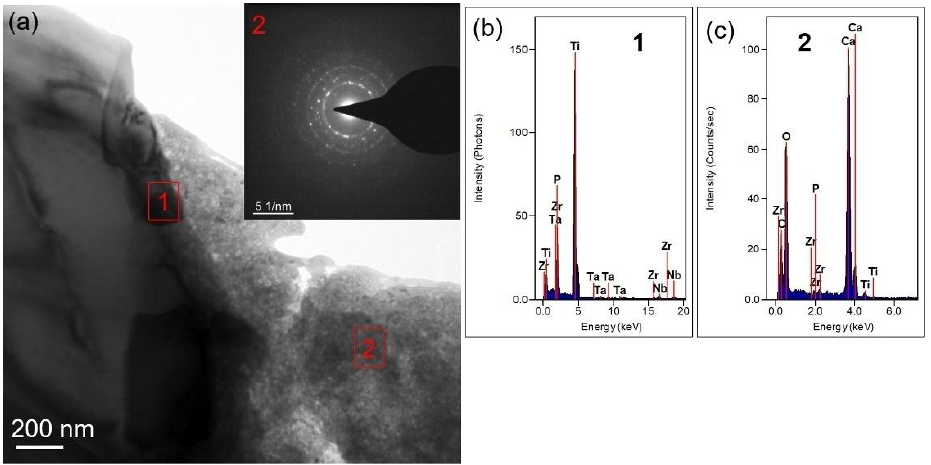
Figure 7. ( a ) Transmission electron microscope (TEM) image of the 0.5-GNFs nanocomposite prepared by SPS. The inset shows the selected area diffraction (SAD) pattern of spot 2; ( b , c ) the corresponding EDS results of spots 1 and 2.